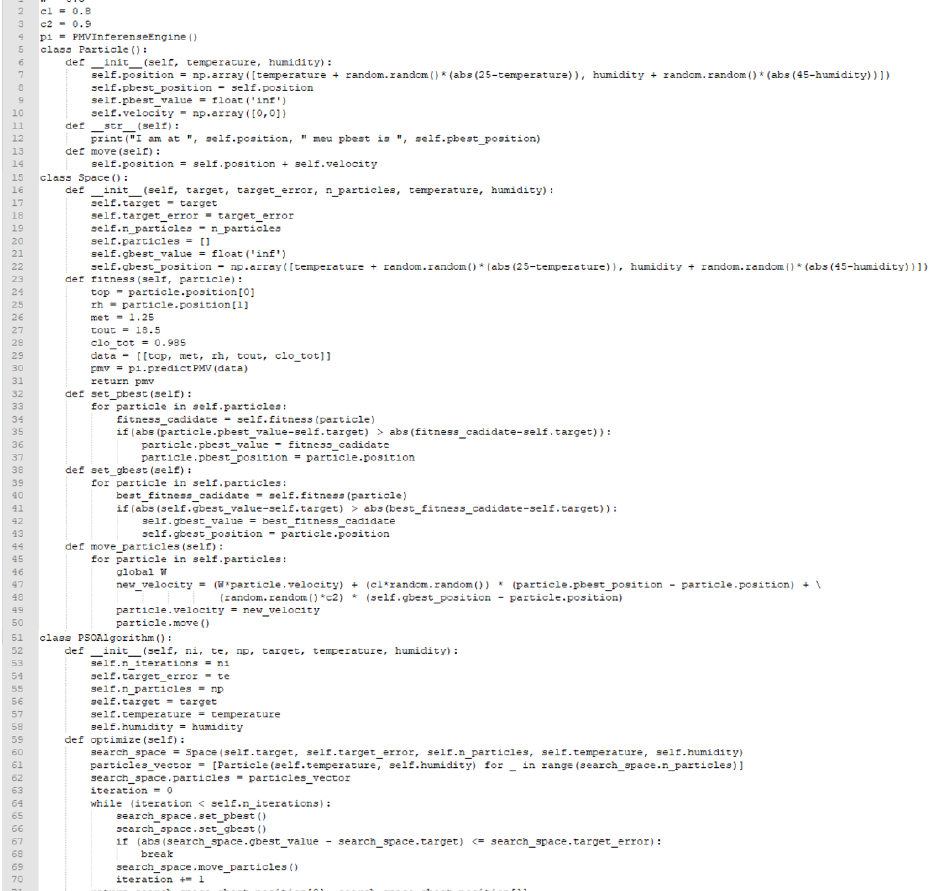
Figure 6. Source Code of Implemented PMV based PSO Algorithm.